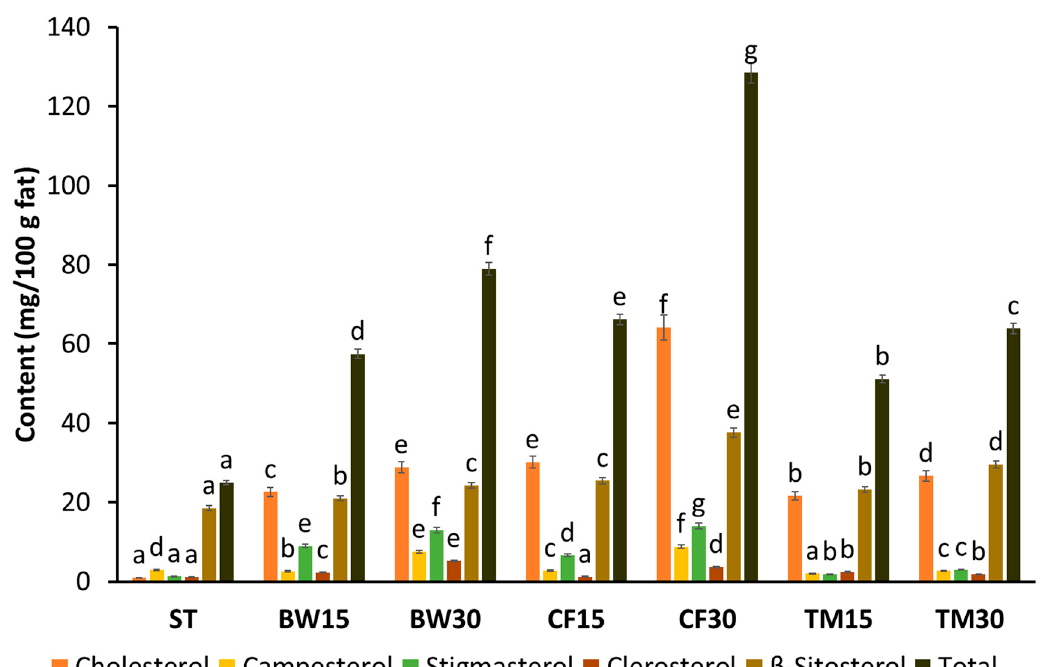
Figure 2. Composition of sterols in the standard and edible insect flour-substituted bars (Values marked with the same letter do not differ statistically significantly at p <